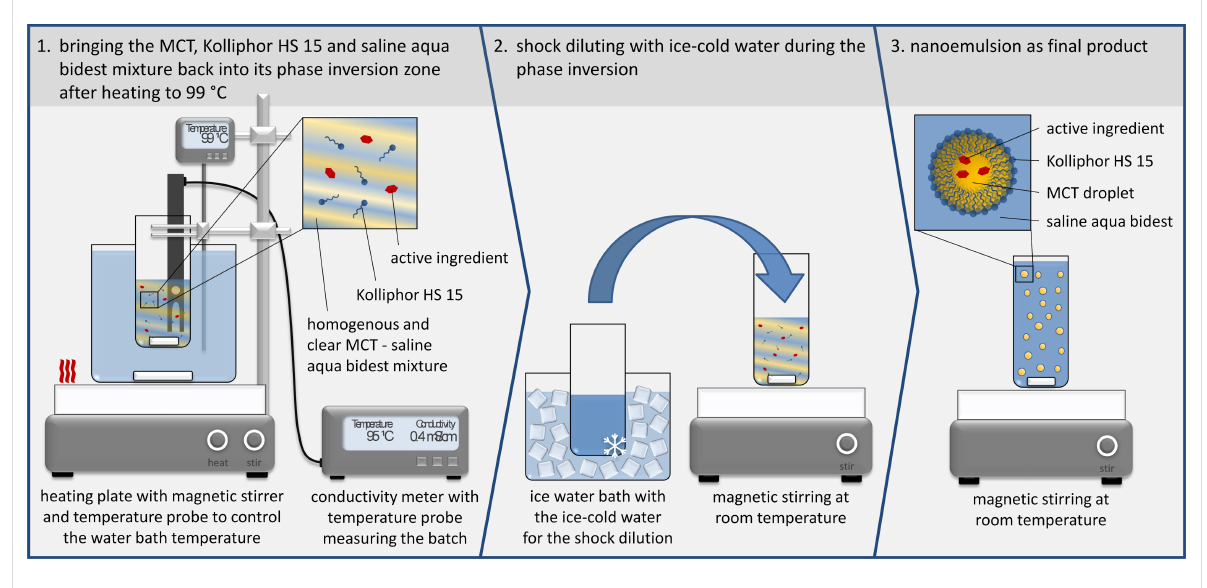
Figure 9: Scheme of the experimental set-up and the method of phase inversion-based production of the nanoemulsions.